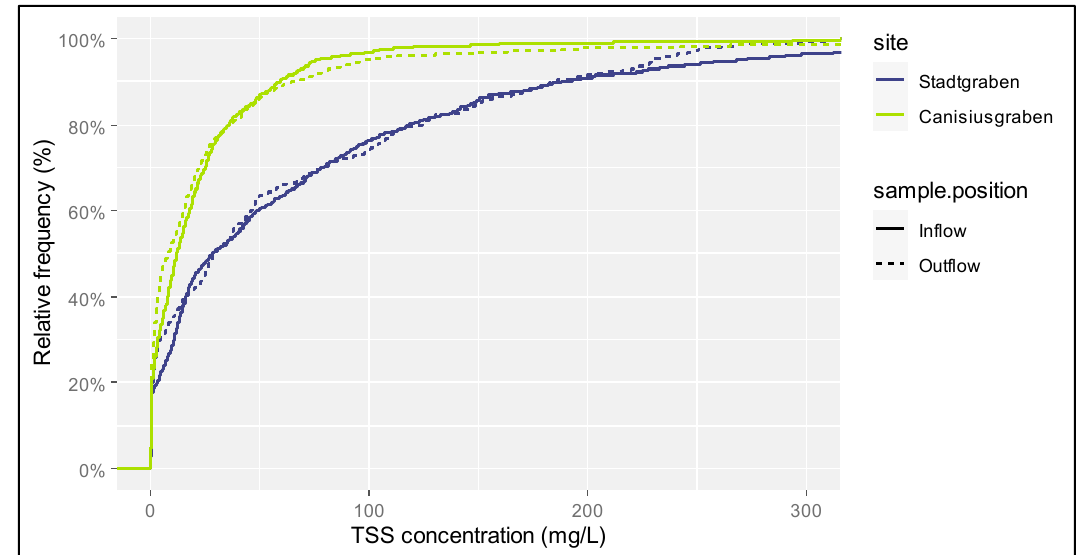
Figure 2. Empirical distribution function of TSS concentration differentiated by site and sample position. TSS concentration data are limited to 300 mg/L of max value of 1300 mg/L to highlight the differences in the dominant data range (cf. Appendix A1 Table A1).